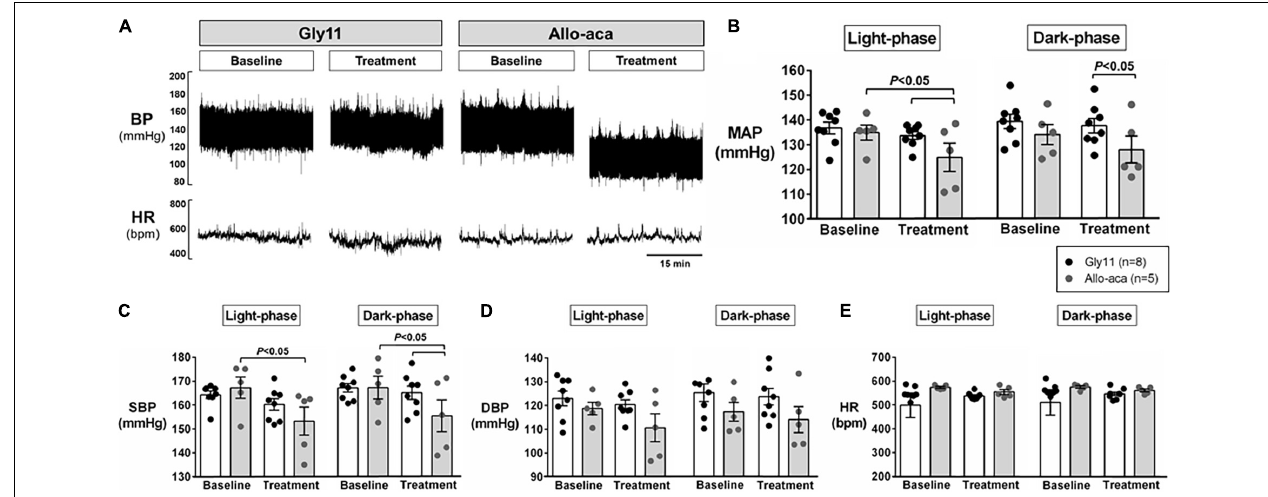
FIGURE 2 | Systemic blockade of leptin receptor with Allo-aca attenuated hypertension in NZO mice. (A) Representative trace of blood pressure (BP) and heart rate (HR) recordings during light-phase at baseline and after the treatment with Allo-aca and control peptide. (B) Mean arterial pressure (MAP) significantly decreased with Allo-aca treatment compared to baseline and to control peptide Gly11 during light-phase. Blockade of leptin receptors reduced (C) systolic blood pressure (SBP) during light and dark-phase, but did not change (D) diastolic blood pressure (DBP) and (E) heart rate (HR). Graphs shown as averaged 24-h BP/HR ± standard errors. Mixed regression model.